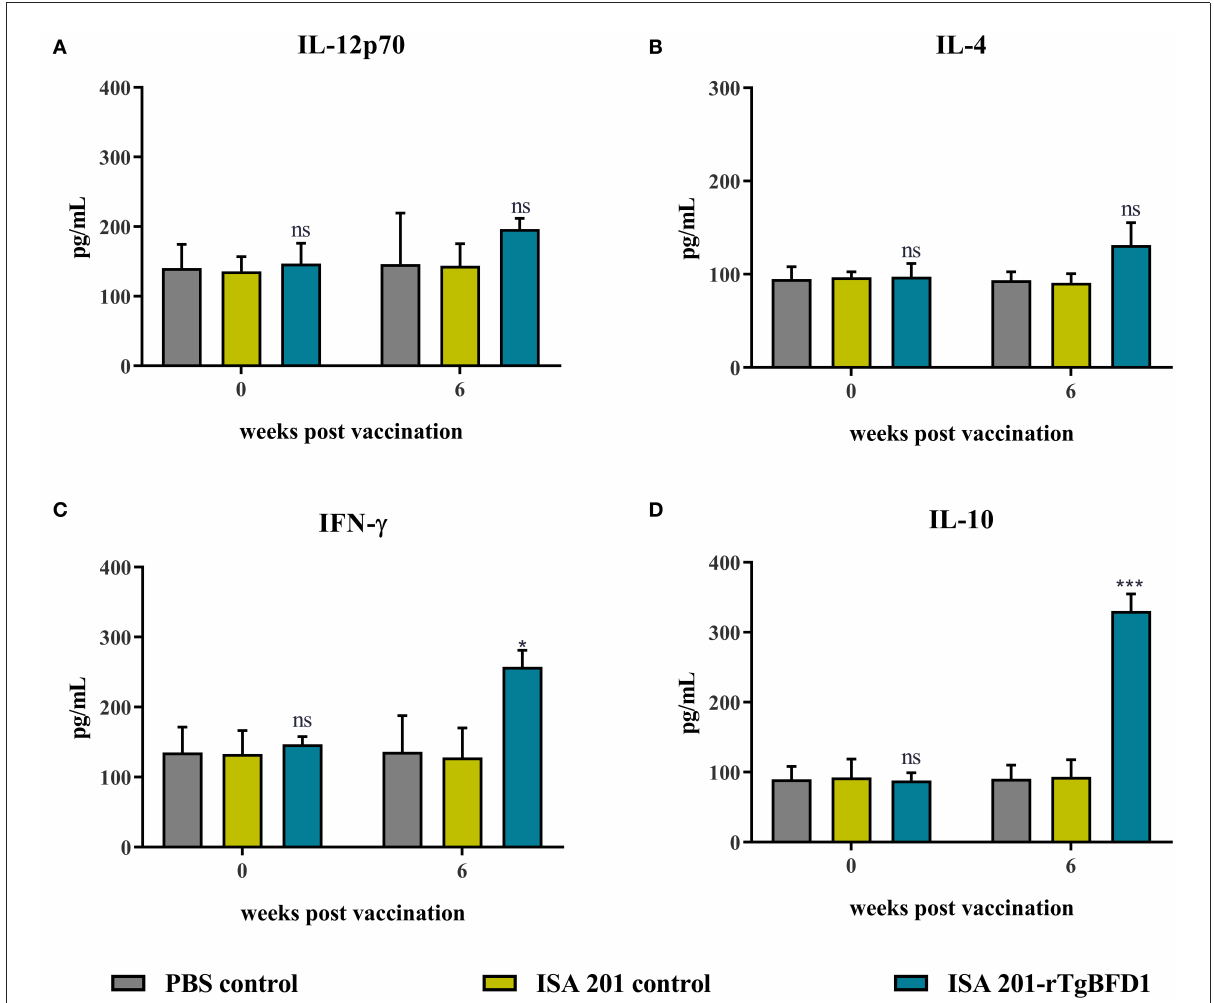
FIGURE5 Multiple cytokines IL-12p70 (A), IL-4 (B), IFN- γ (C), IL-10 (D) concentrations of rTgBFD1 vaccinated mice at 0- and 6-weeks post-immunization. Data were shown as mean ± SEM from ten mice per group and analyzed by a one-way ANOVA. * p < 0.05, *** p < 0.001 and ns compared with the PBS control and the ISA 201 adjuvant group.